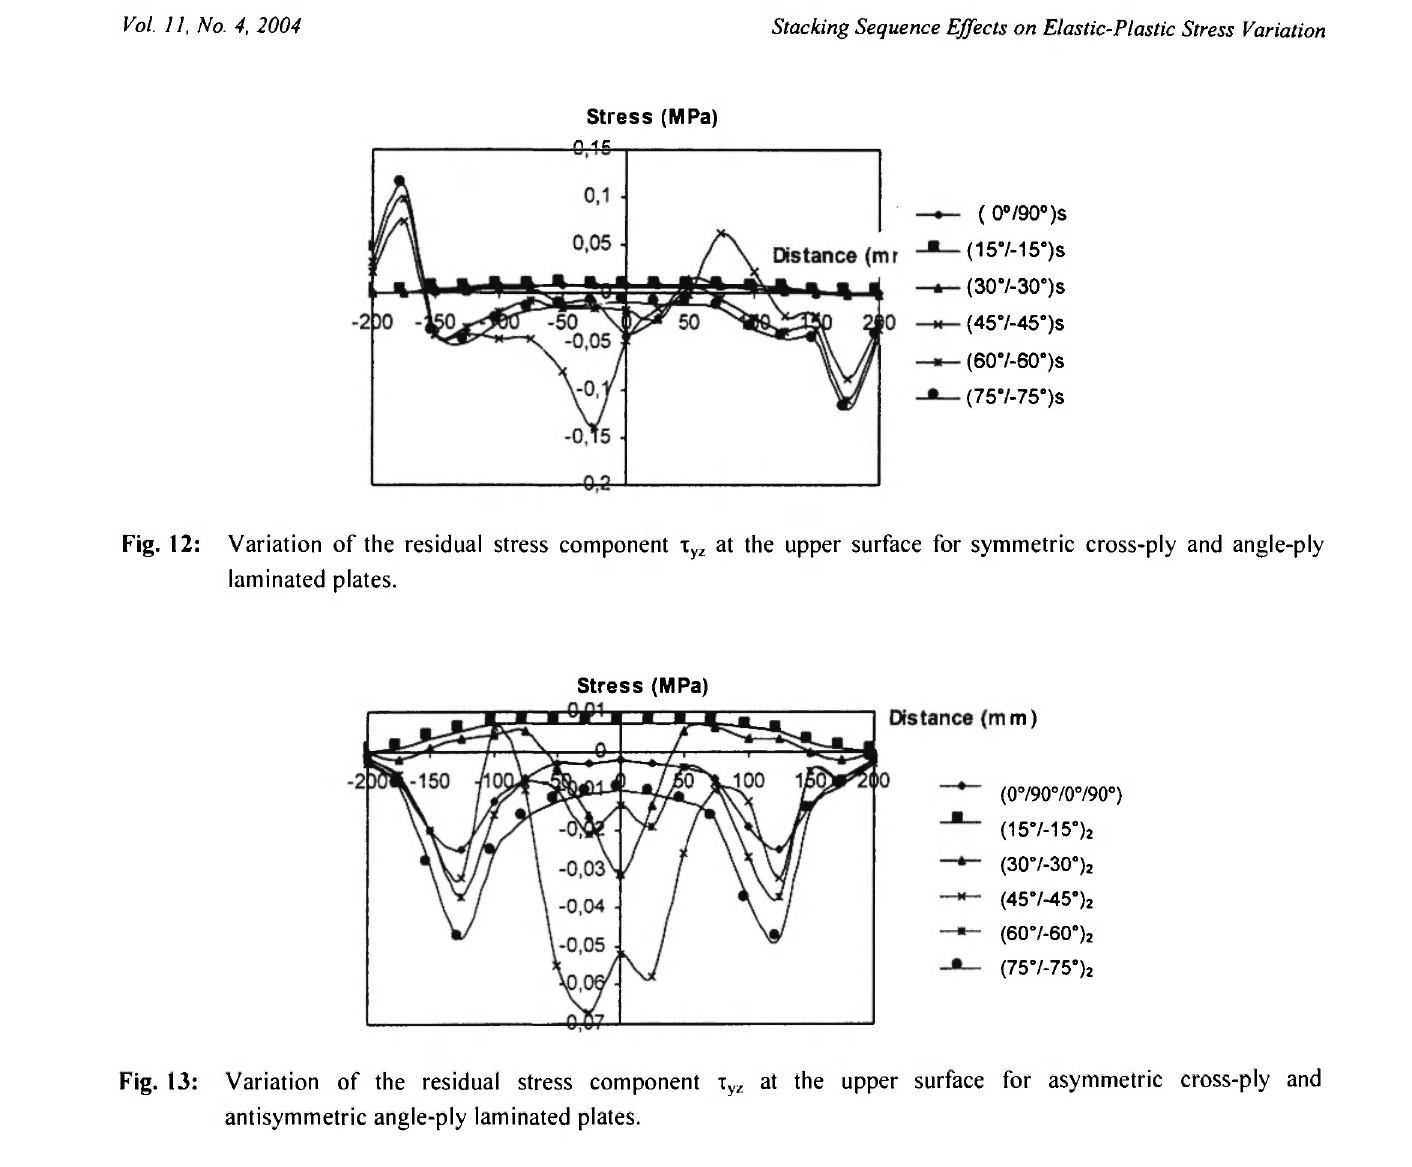
Fig. 13: Variation of the residual stress component t yz at the upper surface for asymmetric cross-ply and antisymmetric angle-ply laminated